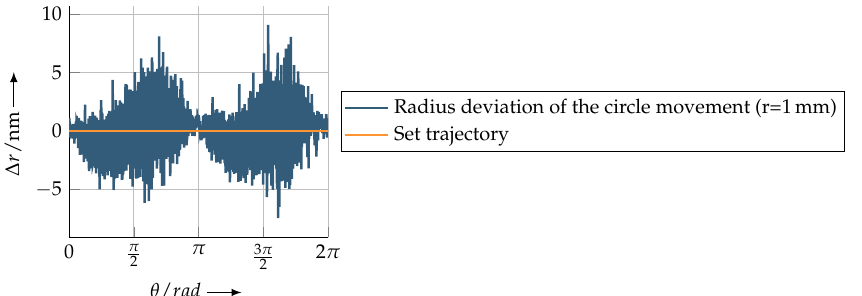
Figure 11. Radius deviation of a circle movement with 1 revolution ( θ = 2 π , unwinding of circle in Figure 10).